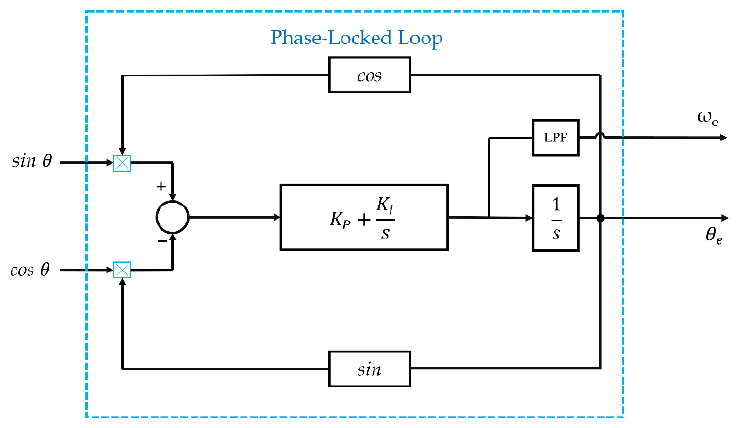
Figure 11. Phase-locked loop architecture.